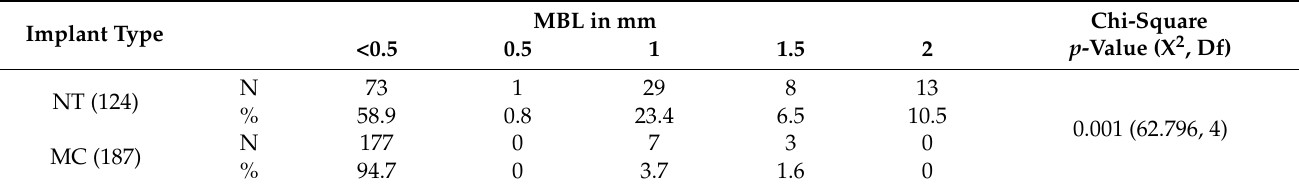
Table 2. Association between MBL in mm and the implant type.